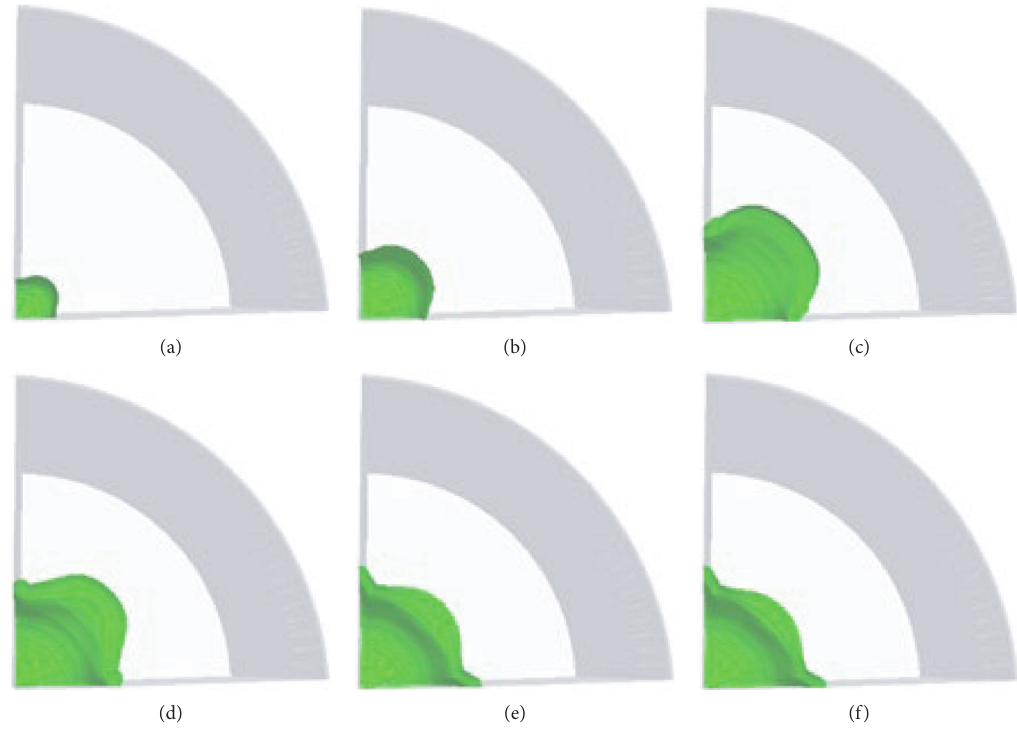
Figure 14: The development of rock mass fracture zone in bird’s-eye view: (a) 0.5ms; (b) 0.8ms; (c) 1.5 ms; (d) 2.0ms; (e) 2.5ms; (f) 3.0 ms.